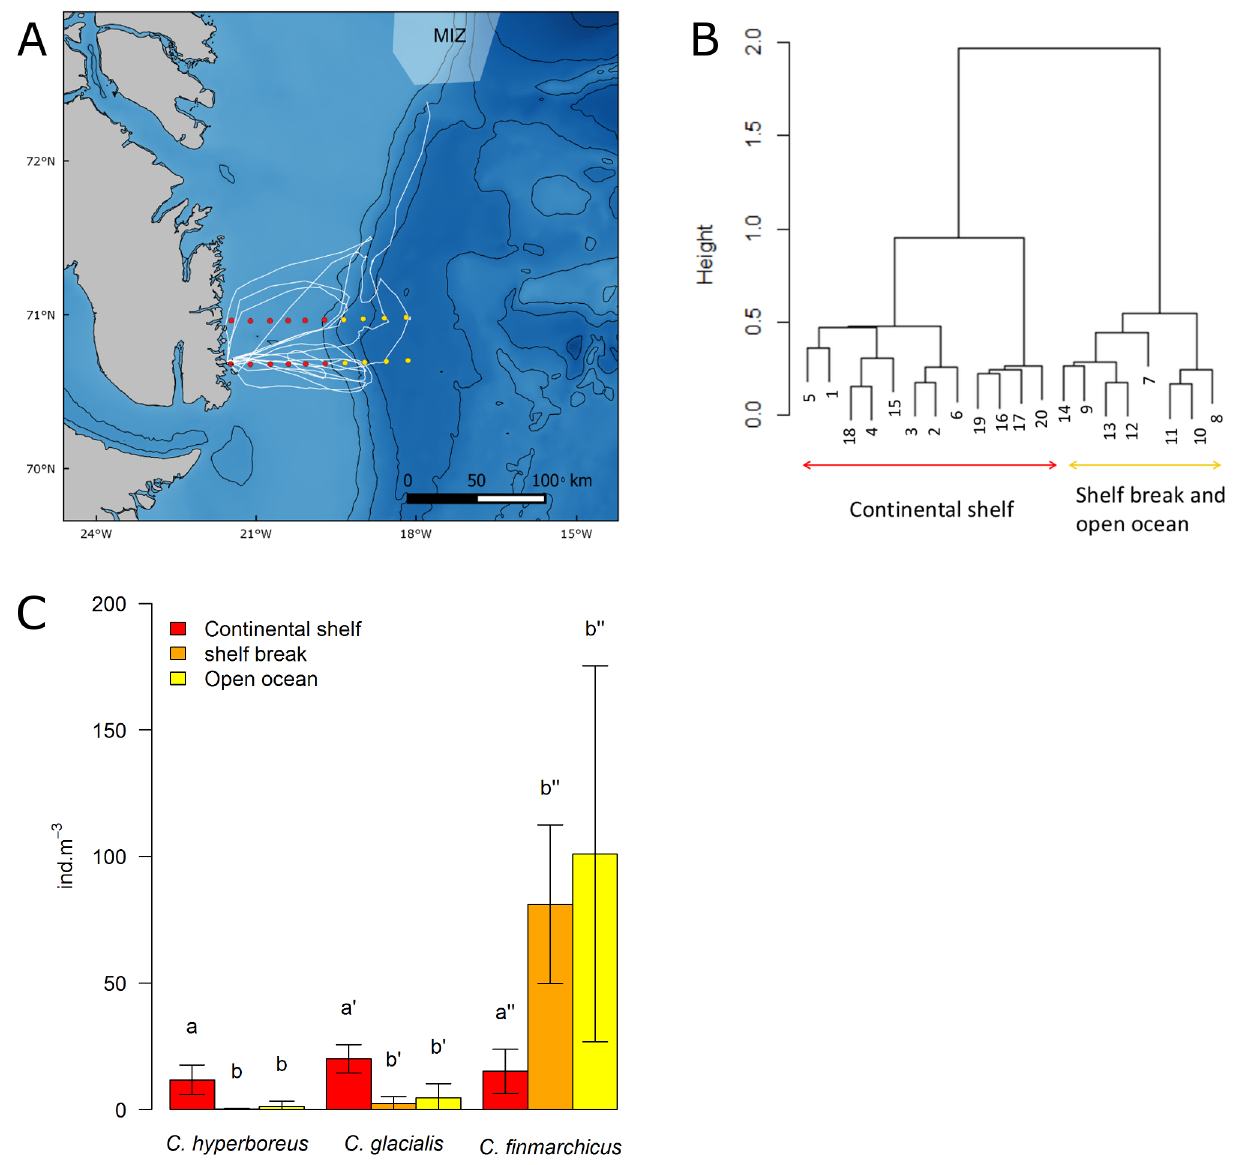
Fig 5. Zooplankton communities sampled along two transects in 2014. (A) Location of zooplankton sampling transects, little auk GPS tracks for 2014 (white line), bathymetry (black lines: 500-m isobaths) and sea ice extent (17 August 2014, only the marginal ice zone (MIZ) is present). (B) Cluster dendrogram of zooplankton species composition grouped according to Bray-Curtis distance. This allowed associating samples to a ‘ continental shelf ’ (red) or ‘ open ocean ’ (yellow) community, and those groups/colours are reported on Fig 5A. (C) Number of individuals per m 3 of the 3 Copepod species in the 3 marine habitats defined by bathymetry. For each species, means with different letters are significantly different (Wilcoxon test, p <